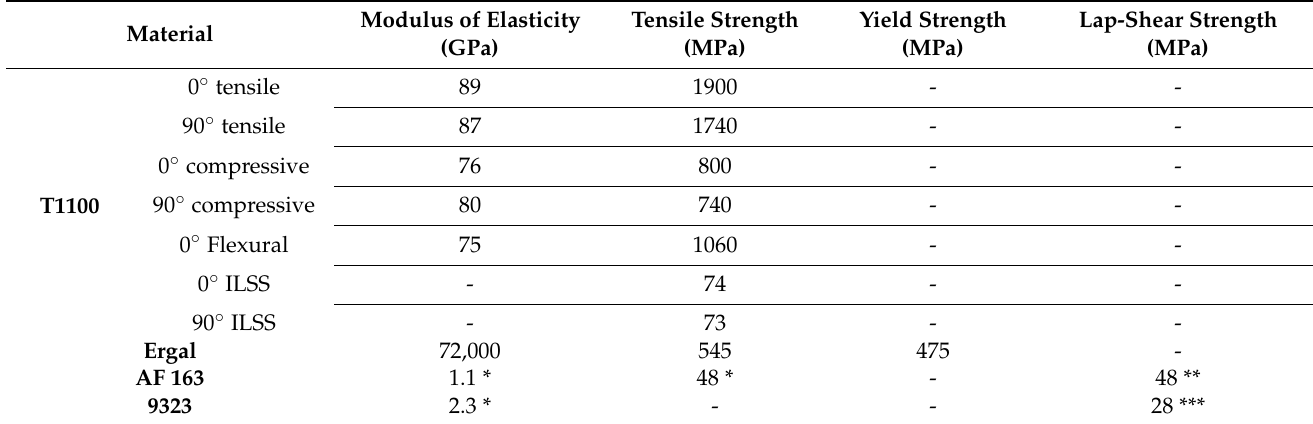
Table 1. Properties at environmental temperature of the materials used in this work (from supplier datasheet except EC 9323, which was tested in [18]; ILSS = InterLaminar Shear